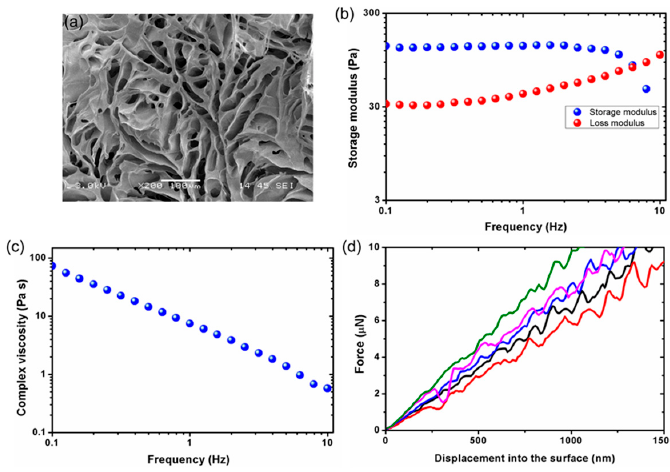
Figure 7. Characterization of 2% HA-MA hydrogel: ( a ) SEM image of a cross-section of dried hydrogel sample showing the network of pores; ( b ) Frequency sweep plot showing the constant stiffness of hydrogel independent of frequency range up to 3 Hz; ( c ) Complex viscosity plot showing shear thinning behavior with increasing frequency; ( d ) Nanoindentation plot showing force-displacement curves for five hydrogel surface locations.